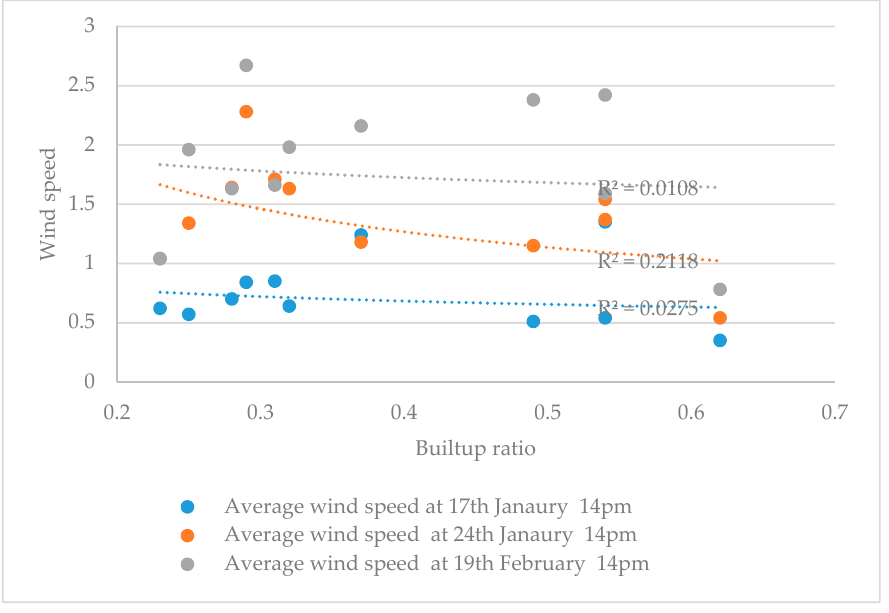
Figure 12. Average wind speed and built-up ratio on 17th, 24th January, and 19th February at 2 pm. Table 19. Summary of average wind speed value on 17th (A), 24th January (B), 19th February (C) at 2 pm and built-up ratio in Compact arrangments.